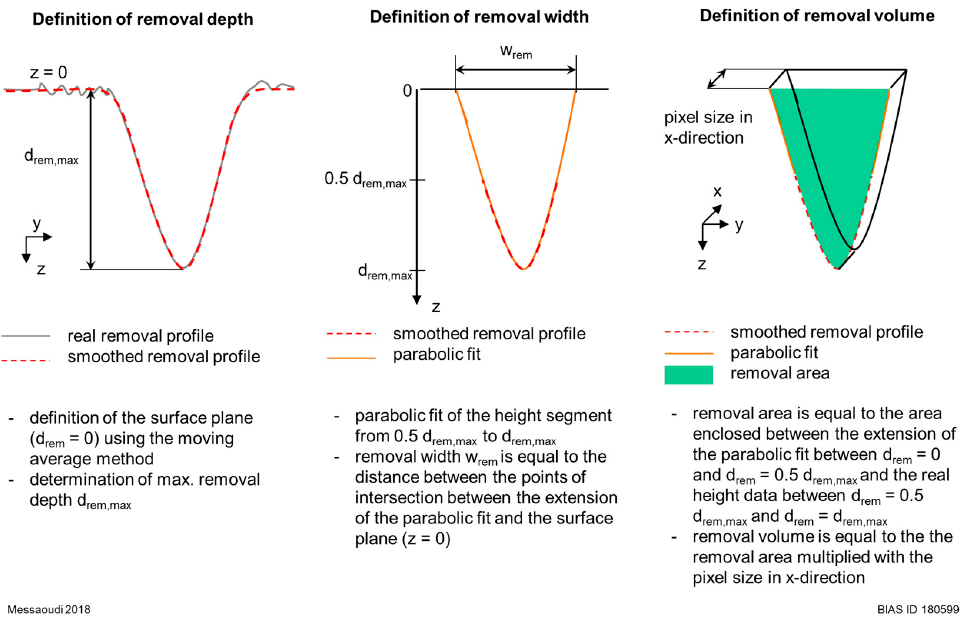
Figure 2. Schematic illustration of the main steps used to determine the removal cavity characteristics: removal depth d rem , width w rem and volume V rem .